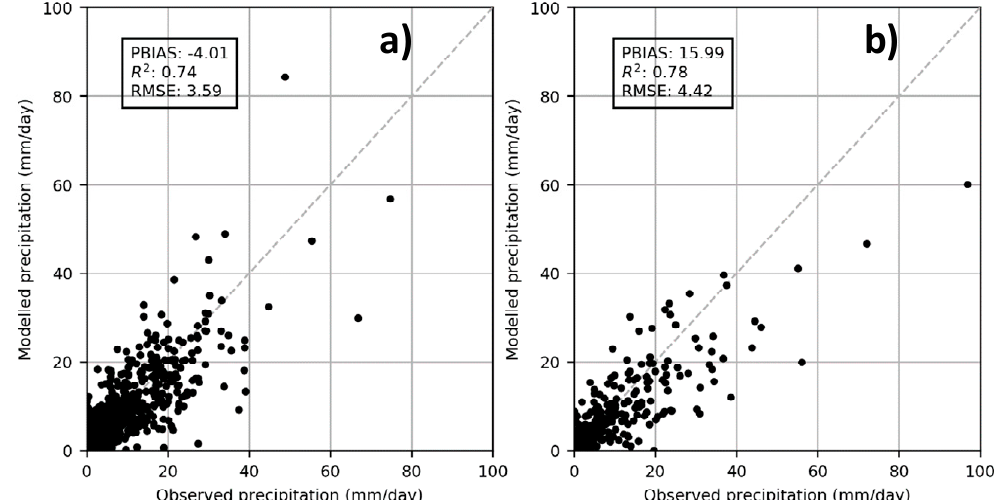
Figure 3. Validation of precipitation data measured at Melide ( a ) and Santiago ( b ) meteorological